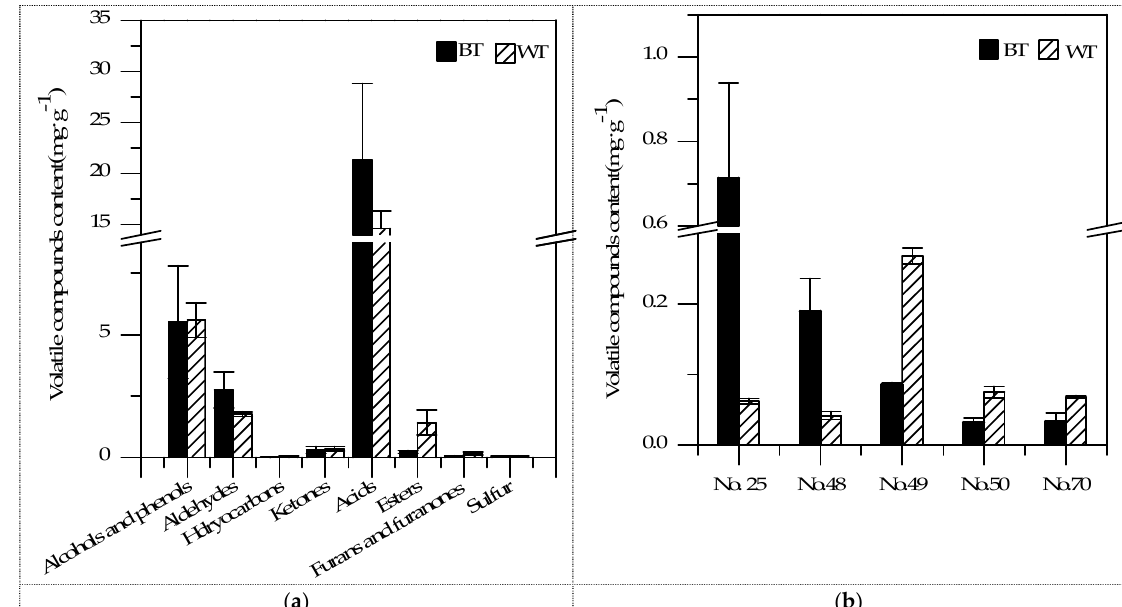
Figure 3. Contents of volatile compounds detected in BT and WT: ( a ) volatiles classified by chemical families; ( b ) volatiles with a significance value lower than 0.05 (No. 25: 5-ethylcyclopent-1- enecarboxaldehyde; No. 48: heptanoic acid; No. 49: octanoic acid; No. 50: nonanoic acid; No. 70: 3-(methylthio)propanoic acid).